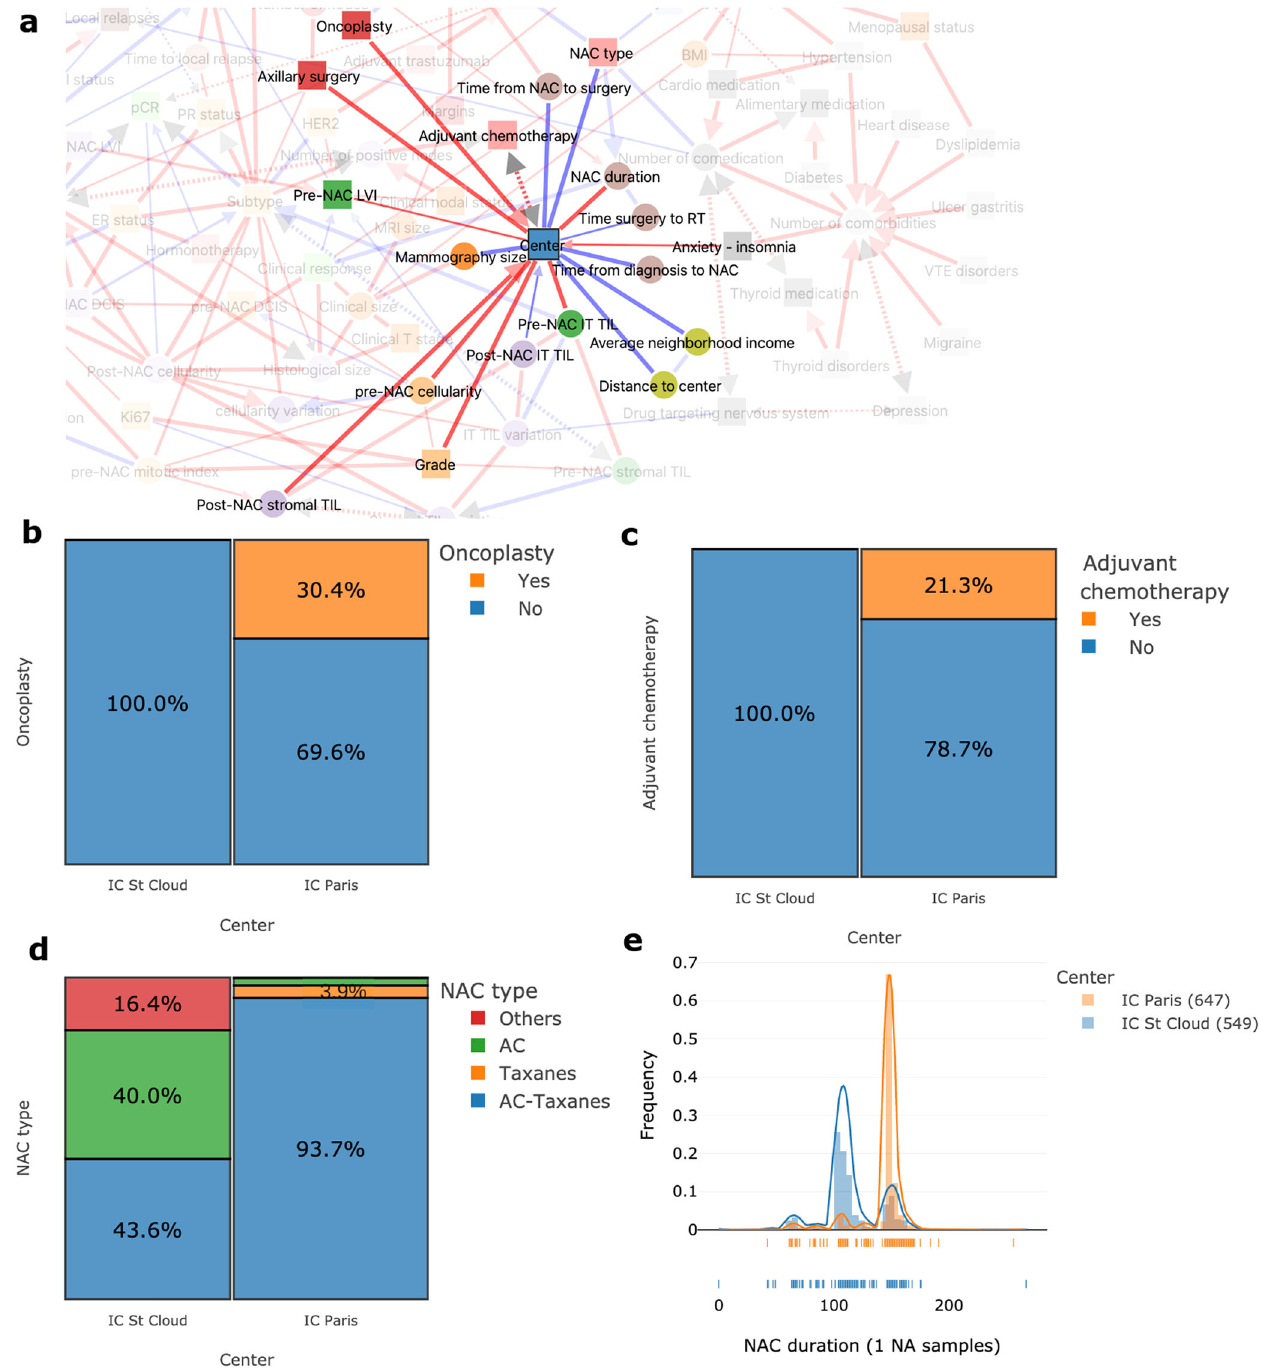
Fig. 3 MIIC identi fi es differences in clinical practices between the two centers of the cohort. a Network interactions around the node “ center ” of treatment. b Proportion of patients undergoing oncoplastic surgery, according to treatment center: Paris or St Cloud. c Proportion of patients receiving adjuvant chemotherapy according to treatment center: Paris or St Cloud. d Proportion of the various NAC regimens according to treatment center. e Distribution plot for NAC duration in days, according to treatment